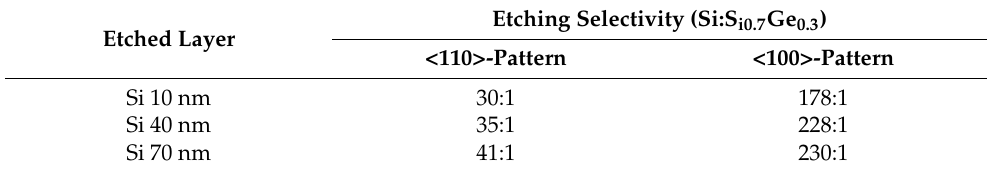
Figure 10. Selective etching of Si layer with various thicknesses in ( a ) <110>-patterned and ( b ) <100>-patterned Si 0.7 Ge 0.3 /Si/Si 0.7 Ge 0.3 multi-layer using TMAH. Table 3. Etching selectivity of Si:Si 0.7 Ge 0.3 in the <110>- and <100>-patterned multi-layered wafer. Etched